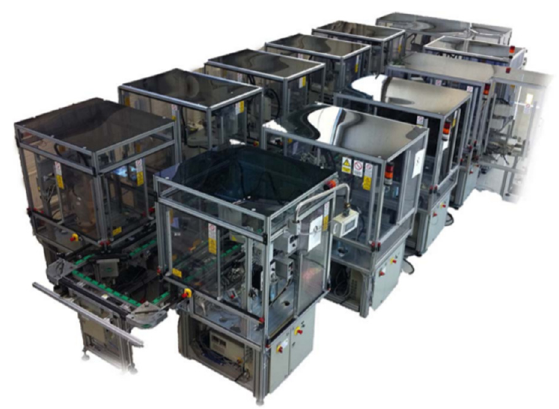
Figure 3. FASTory production assembly line [27].